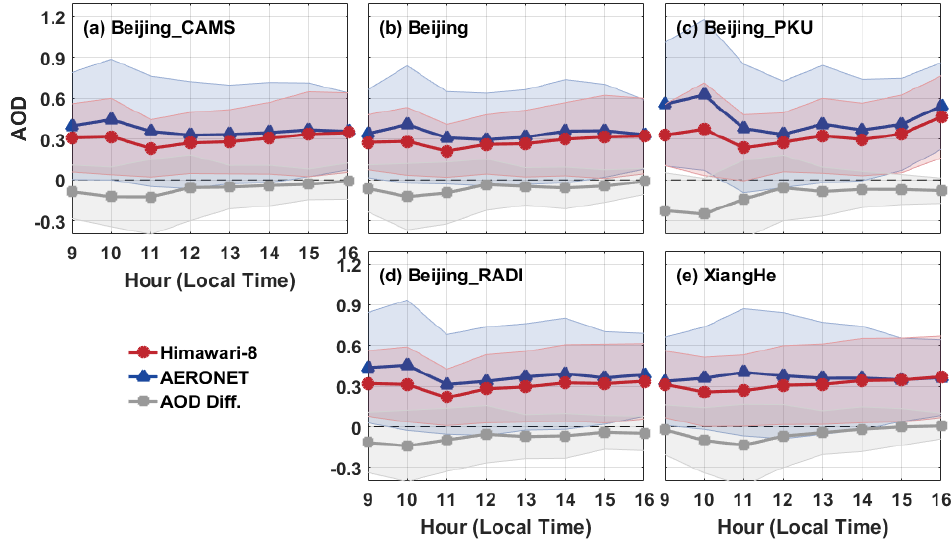
Figure 3. Time series of hourly AODs of Himawari-8 and AERONET, and hourly AOD difference between Himawari-8 and AERONET from the collocated matchups and standard deviations (shadows) over ( a ) Beijing_CAMS, ( b ) Beijing, ( c ) Beijing_PKU, ( d ) Beijing_RADI, and ( e ) Xianghe. The study period is from July 2015 to March 2017.